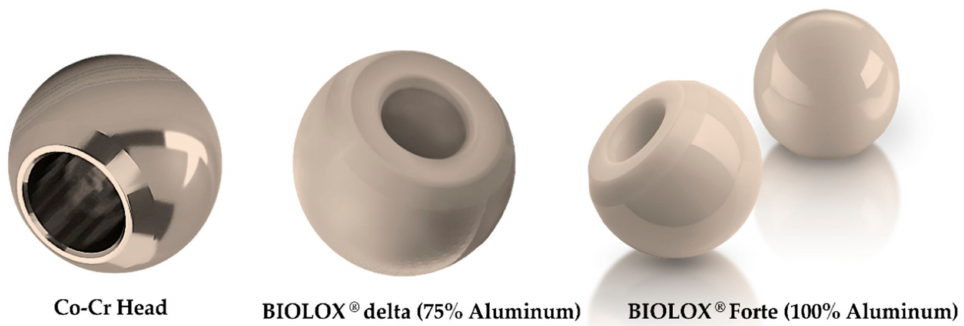
Figure 3. Acetabular heads of different biomaterials and brands